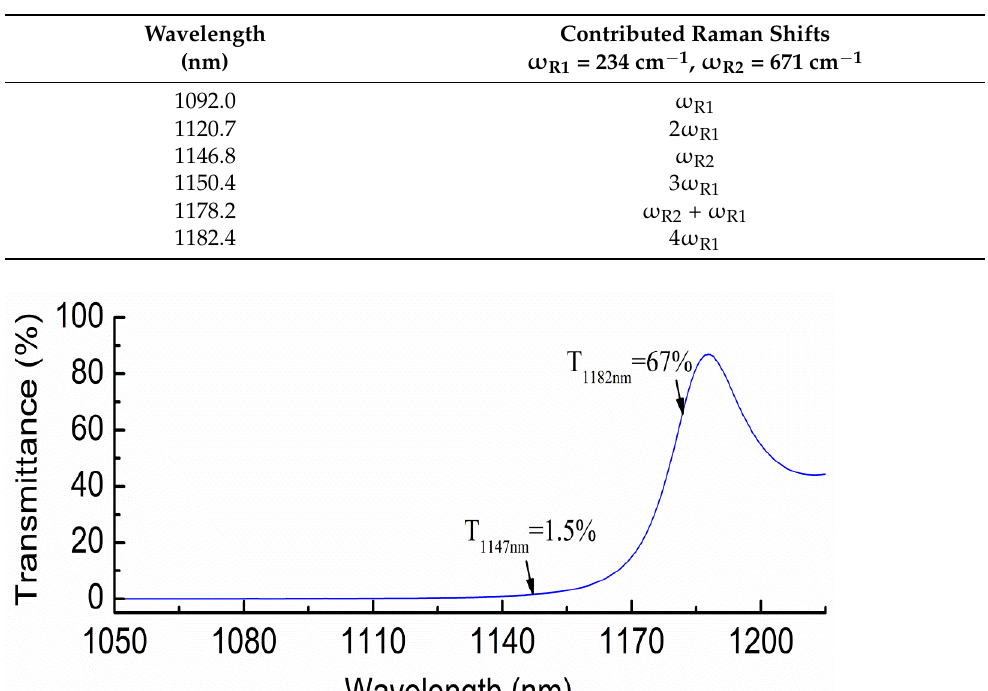
Table 1. Stokes wavelengths with contributed Raman shifts.